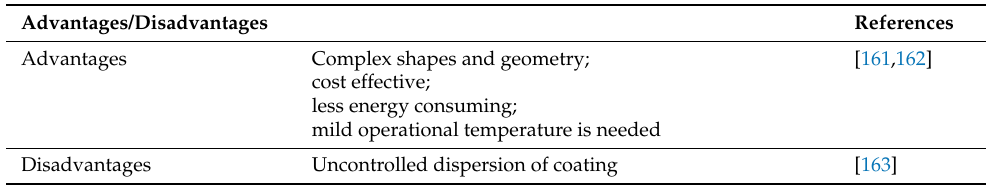
Table 7. Some of the significant advantages and disadvantages of hydrothermal treatment are mentioned in this table.